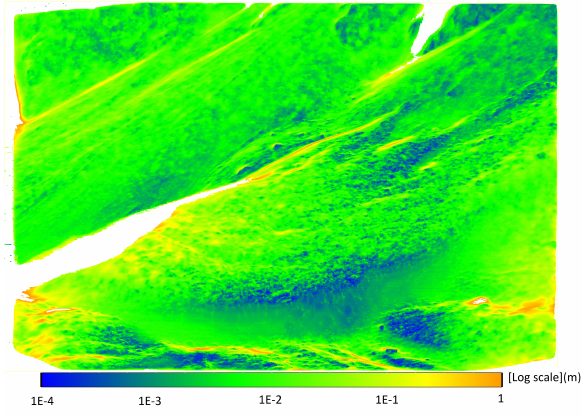
Figure 7. Average standard deviation of depth maps computed on images of the Laurichard rock glacier. The standard deviation map is calculated from a series of 460 depth maps from images taken between July 2018 and October 2018: standard deviation is computed with a sliding of one week. Then all the maps are averaged to produce the final standard deviation